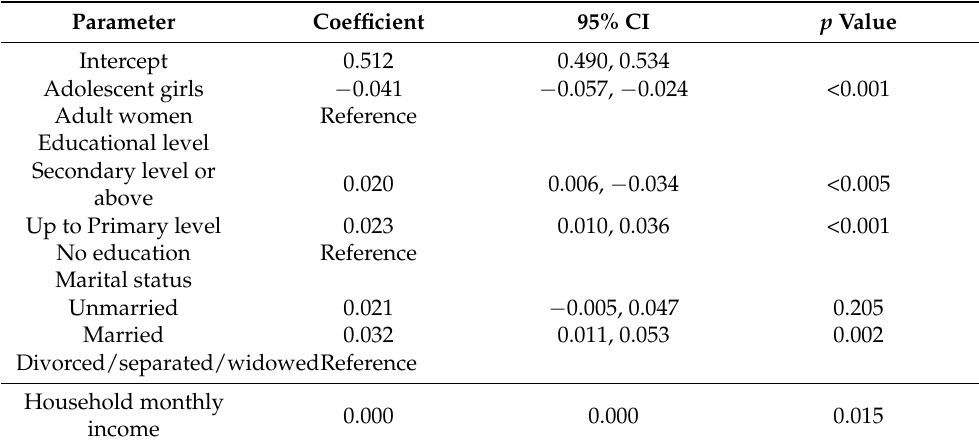
Table 4. Socio-demographic factors associated with the diet quality of WRA using